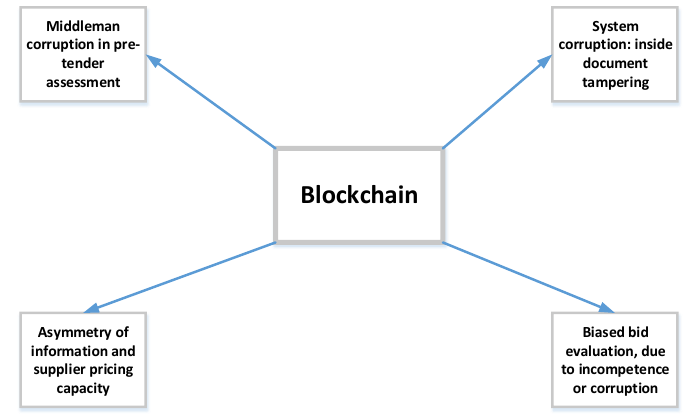
Figure 3: Proposed framework for mitigating procurement corruption in the public